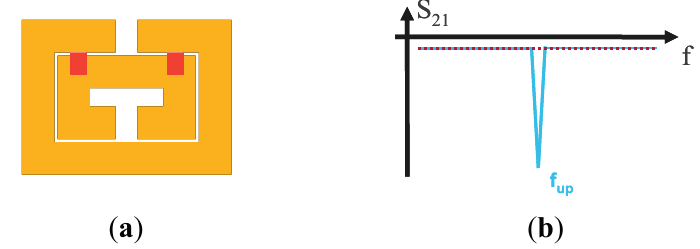
Figure 7. Tunable SRR based on cantilever type RF-MEMS (in red) corresponding to the configuration considered for the implementation of reconfigurable stopband filters ( a ), and sketch of the response of a line loaded with these SRRs for the up (solid line) and down (dotted line) states ( b ).